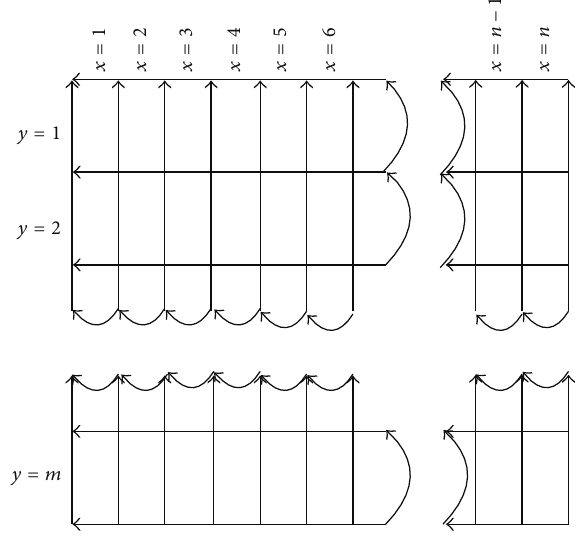
Figure 3: The explanation of RCCSTD problem [9, 12].